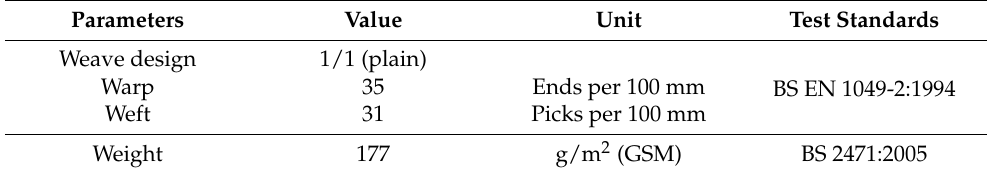
Table 2. Specification of jute fabric.